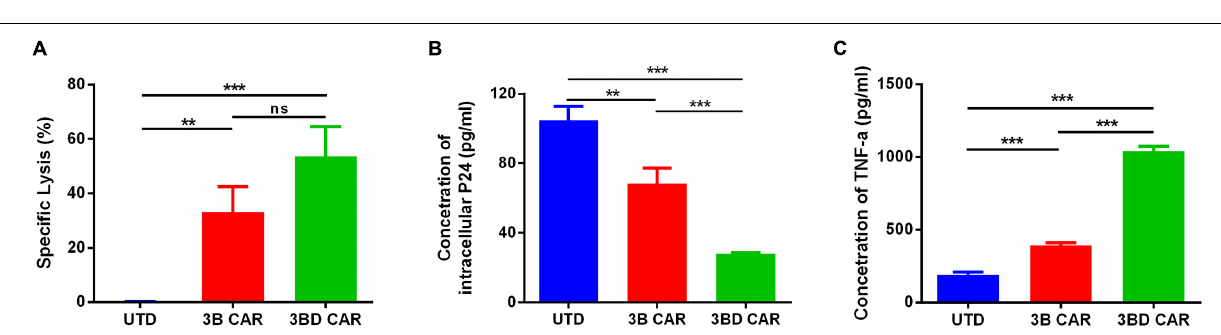
FIGURE 5 | 3B and 3BD CAR-T cells kill latently infected cells. ACH-2 cells were mixed with 3B or 3BD CAR-T cells at a 1:1 ratio. (A) LDH assay was performed to test specific cytotoxicity at day 1. (B) Five days after co-culture, cell pellets were collected, and intracellular P24 was detected by ELISA. (C) Production of TNF- α in the supernatant of co-culture at day 1. Statistical analyses were performed using the one-way ANOVA. ns p > 0.05, ** P < 0.01, *** P < 0.001. Data represent the mean ±